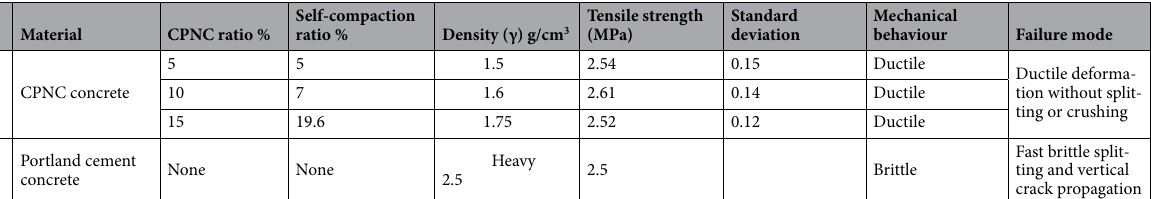
Table 3. Test results of the tensile strength properties of CPNC concrete and CPNC mortar relative to Portland cement concrete proving that CPNC-materials are ductile and that the failure is not splitting or brittle failure; instead, it is ductile deformation without material separation or sudden propagation. The material is lightweight concrete.